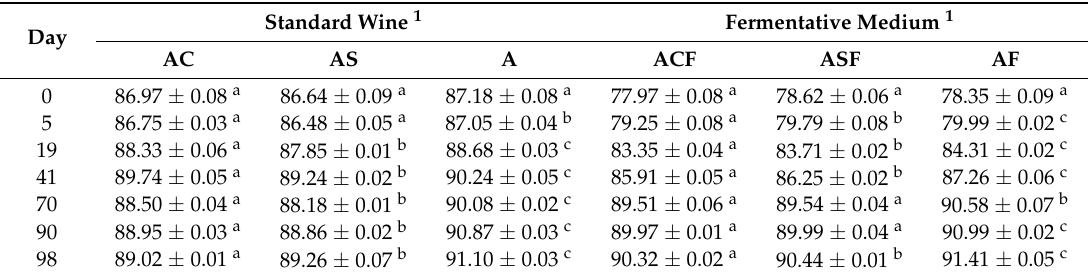
1 AC : Model system in standard wine added with tannin C . AS : Model system in standard wine added with tannin S . A : Reference model system in standard wine. ACF : Model system in the fermentative medium added with tannin C . ASF : Model system in the fermentative medium added with tannin S . AF : Reference model system in the fermentative medium. Different lower case letters within each row and for each type of medium (standard wine or fermentative medium) indicate significant differences ( n = 6, p < 0.05).